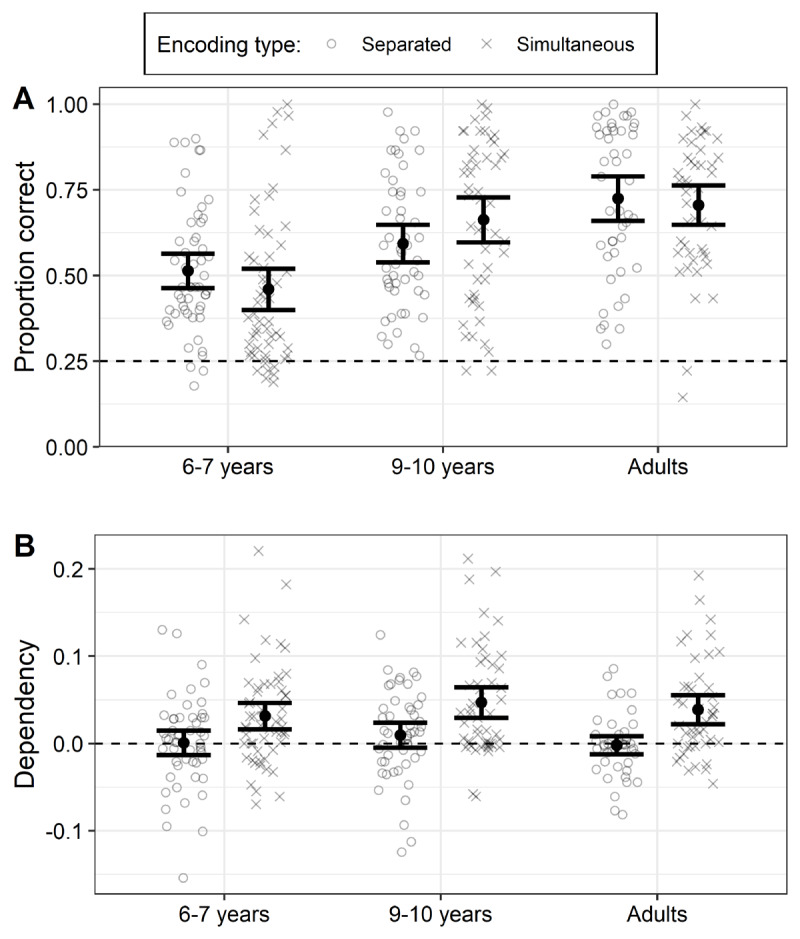
Retrieval accuracy (A) and dependency (B) following separated and simultaneous encoding of event elements.Note: Each data point marks average performance for a single participant, with bold points representing condition means per age group. Error bars mark 95% confidence intervals. In panel A, the dashed line represents chance-level performance. In panel B, the dashed line represents no more dependency in the data than would be predicted by the independent model.